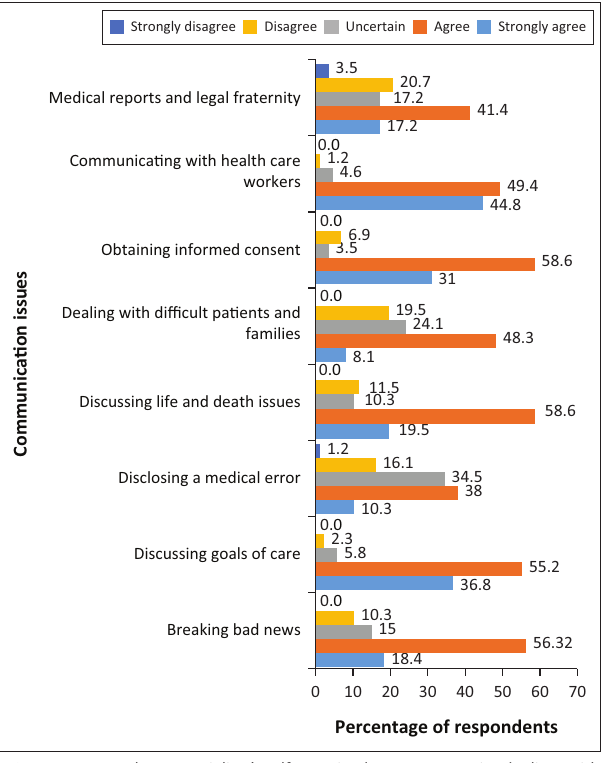
FIGURE 3: Registrars’ self-perceived competency in dealing with neurological communication issues in neurology.